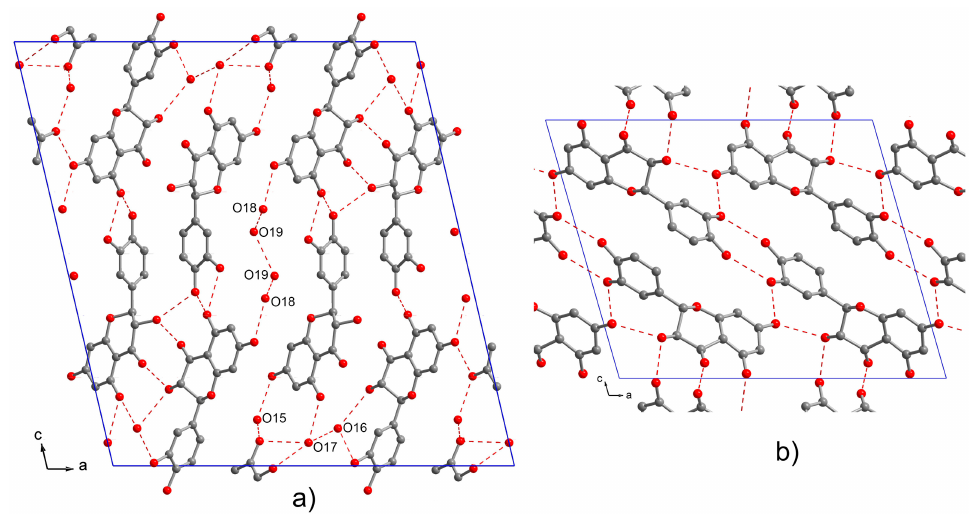
Figure 3. Scheme of the structure of Phase 1 ( a ); and Phase 3 ( b ). Carbon atoms are black, oxygen atoms are red, while hydrogen bonds are represented as dashed lines. Water molecules are labeled as in [34].